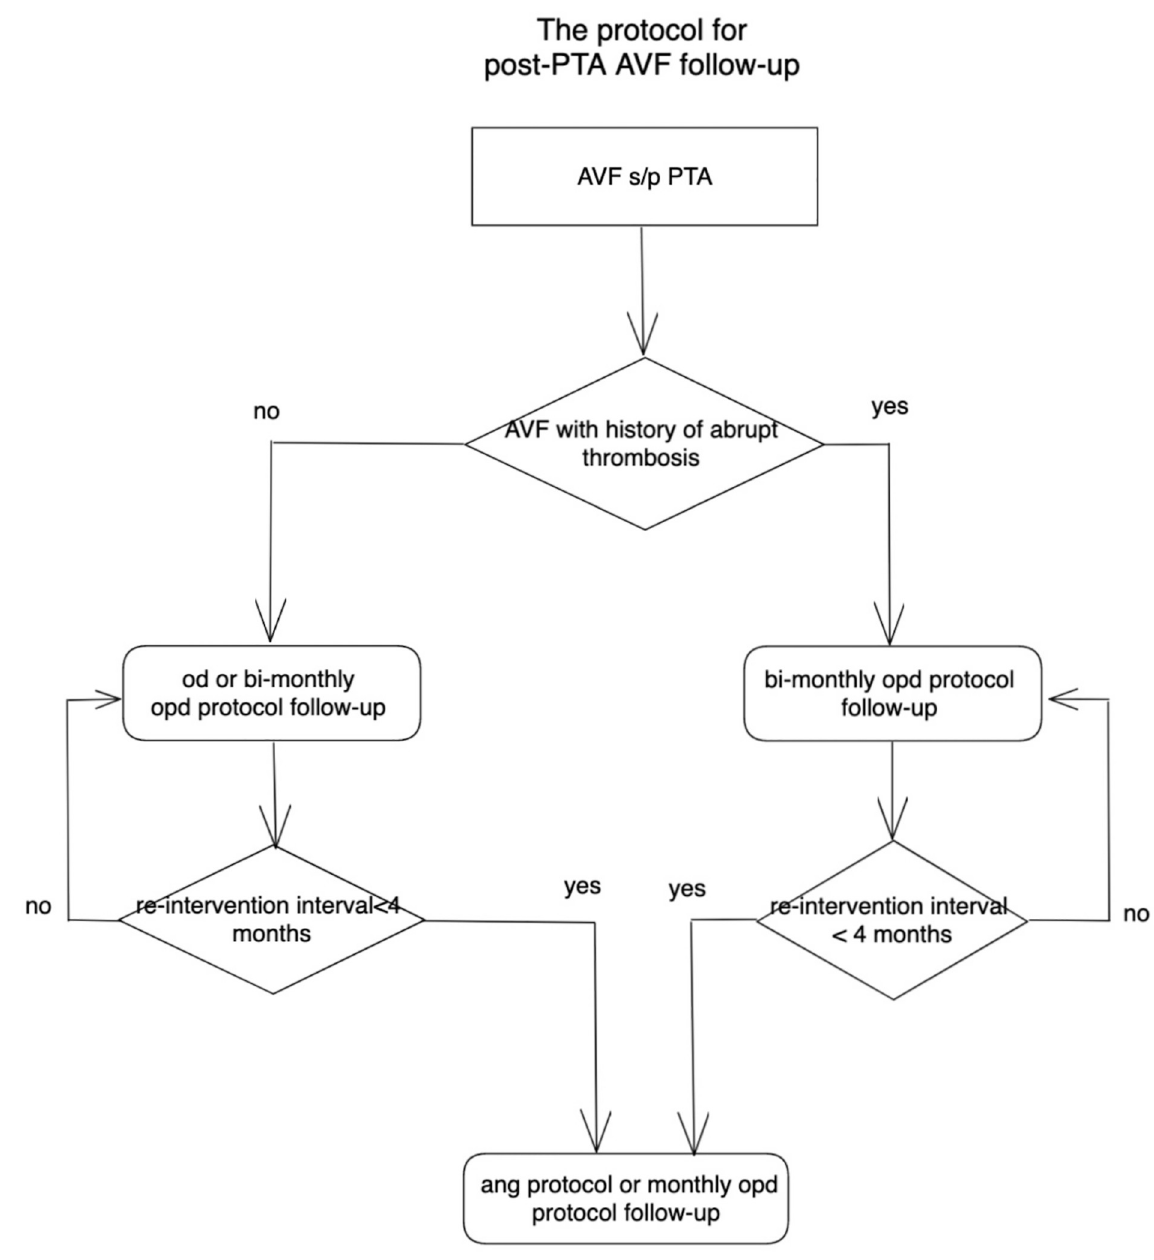
Fig 2. Flow chart for sub-protocol